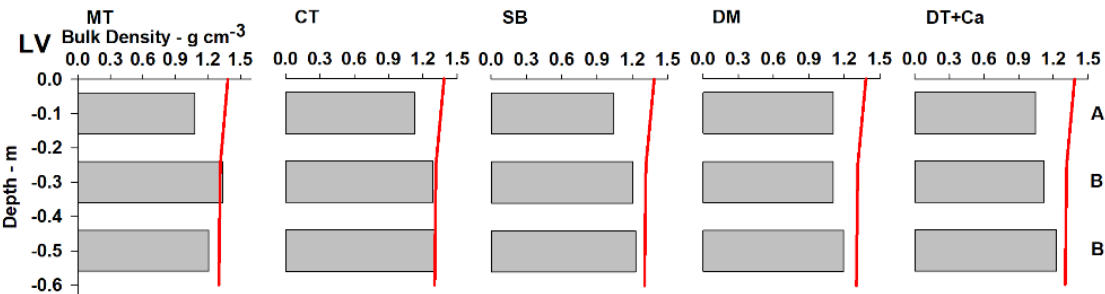
Figure 3. Bulk density (Bd) and critical bulk density (vertical red line) for three soil classes under different soil tillage systems for a perennial crop. Measurements were performed seven months after tillage operations. Mean values followed by the same lowercase letters in the row and uppercase letters in the column do not differ from each other by Tukey’s test ( p < 0.05). MT: minimum tillage with a pit (0.4 m in diameter by 0.7 m deep); CT: conventional tillage (0.25 m deep); SB: subsoiler with booted ripper points on two shanks (0.45 m deep); DT: deep mixing tillage with rotary hoe tiller (0.5 wide by 0.6 m deep); DT + Ca: deep mixing tillage with rotary hoe tiller (0.5 wide by 0.6 m deep) + additional liming; Critical bulk density by according to [72]; (CX: Typic Dystrustept, PV: Rhodic Hapludult, and LV: Rhodic Hapludox).